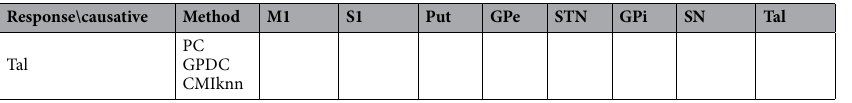
Table 2. Statistical values of each functional link during the motor-task computed with the partial correlation (PC), gaussian process regression and distance correlation (GPDC), and conditional mutual information test (CMIknn) methods. Columns correspond to causative nuclei and rows to response nuclei. Only those relationships with p -values < 0.01 are shown. All the statistical values in this table were normalized between 0 and 1, a procedure that facilitates the comparison of the results obtained with the three methods. M1 primary motor cortex, S1 primary somato-sensory cortex, Put putamen, GPe external globus pallidum, STN